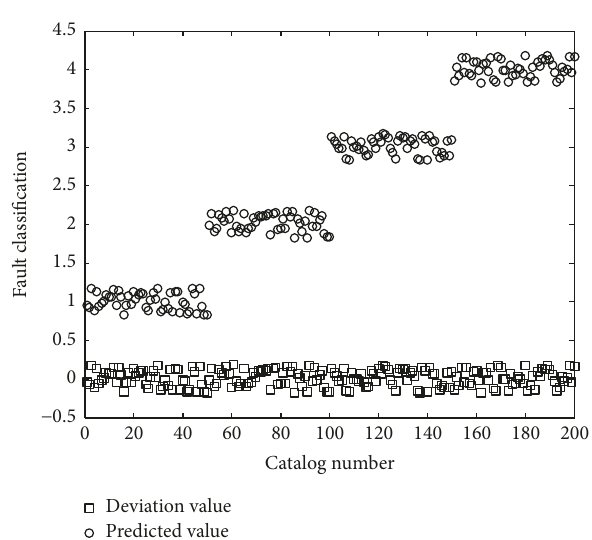
Figure 8: Prediction result of Algo1 for 𝑅1 = 0.1 .